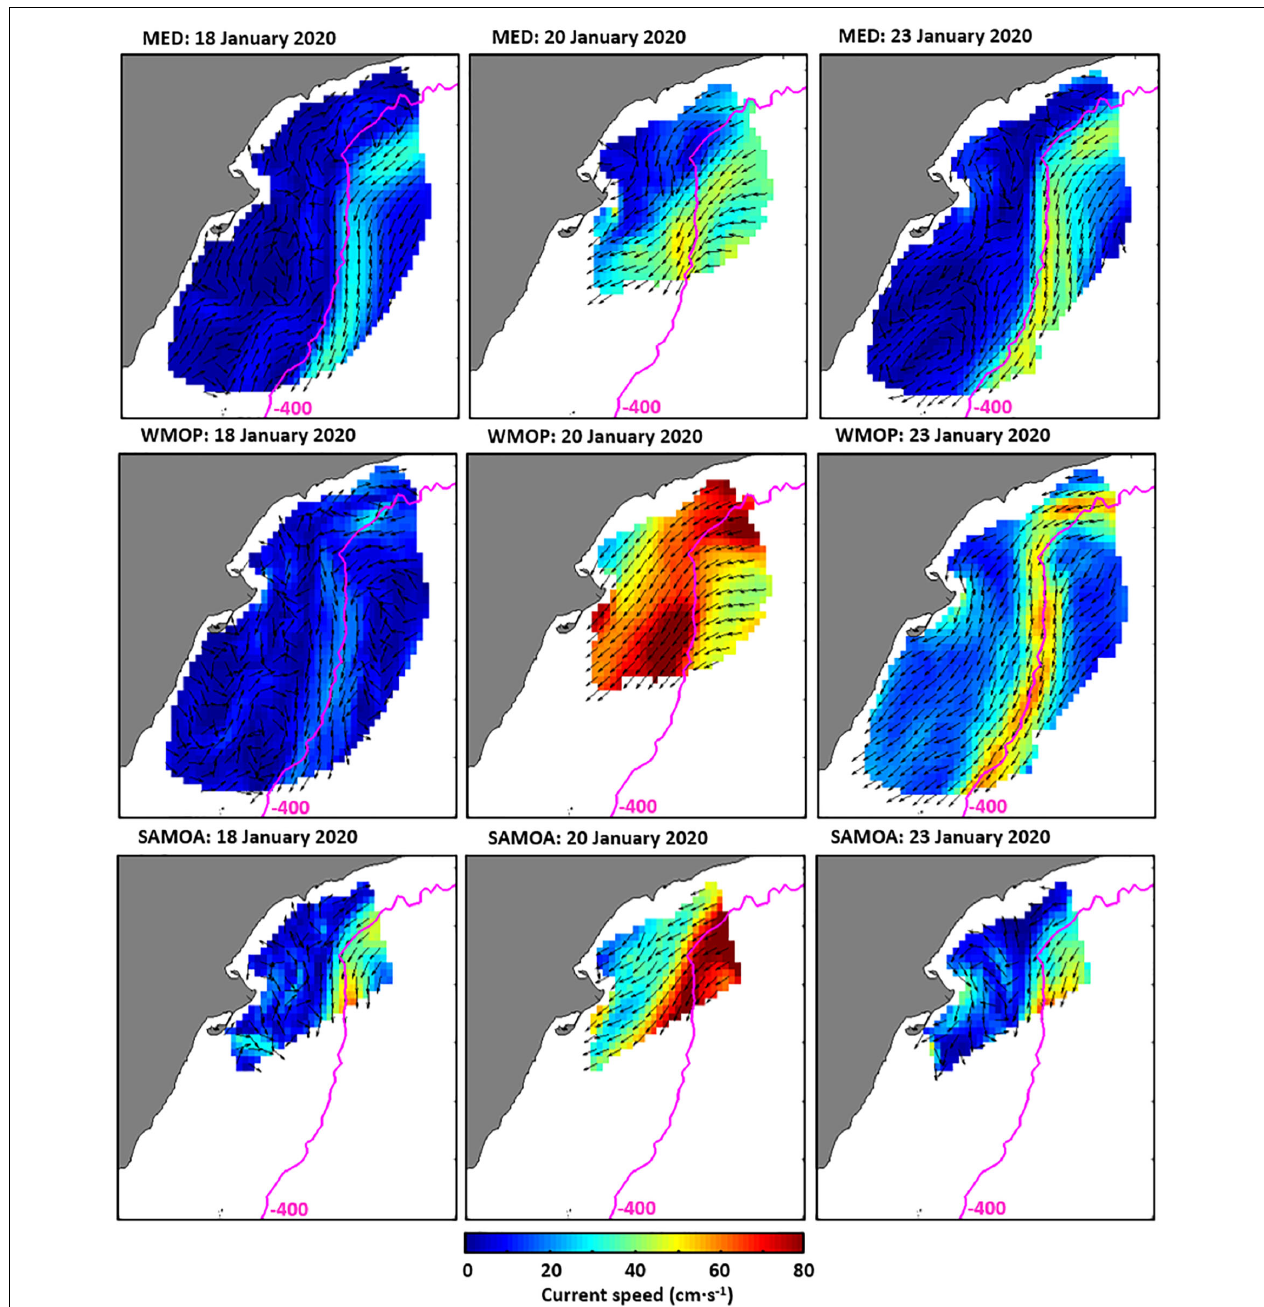
FIGURE 6 | Model validation with HF radars observations: currents at the Ebro delta observed by the HF radar (1st row) and simulated by GLO (2nd row), MED (3rd row), IBI (4th row), WMOP (5th row) and SAMOA (6th row), on the 19th (1st column), 20th (2nd column), and 21st (3rd column) of January.